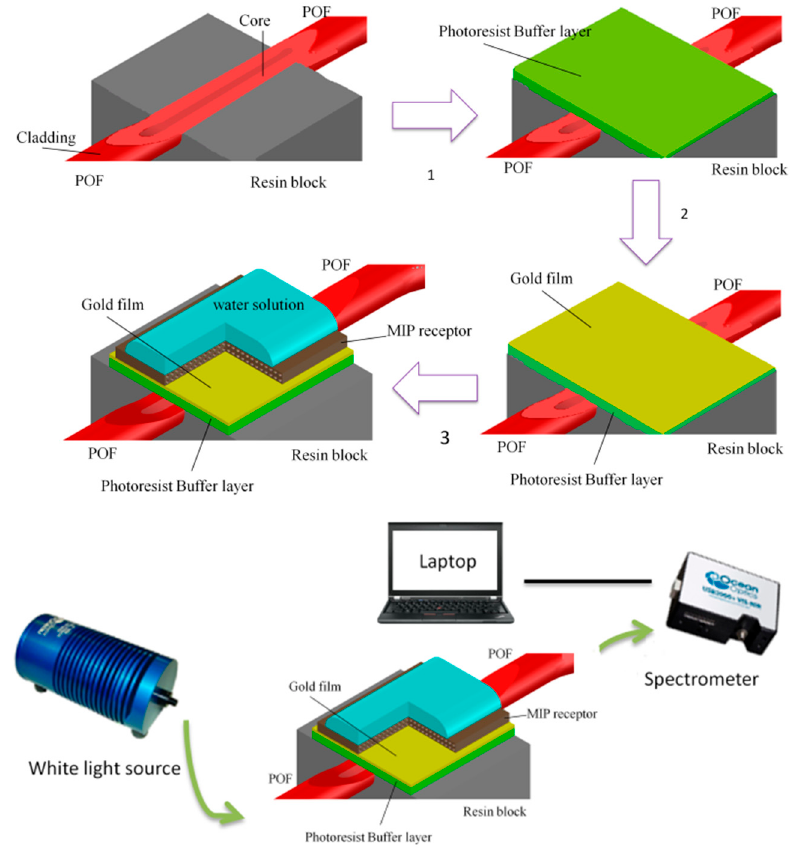
Figure 1. Production steps for realizing an SPR sensor in a D-shaped POF with an MIP receptor and outline of the experimental setup.